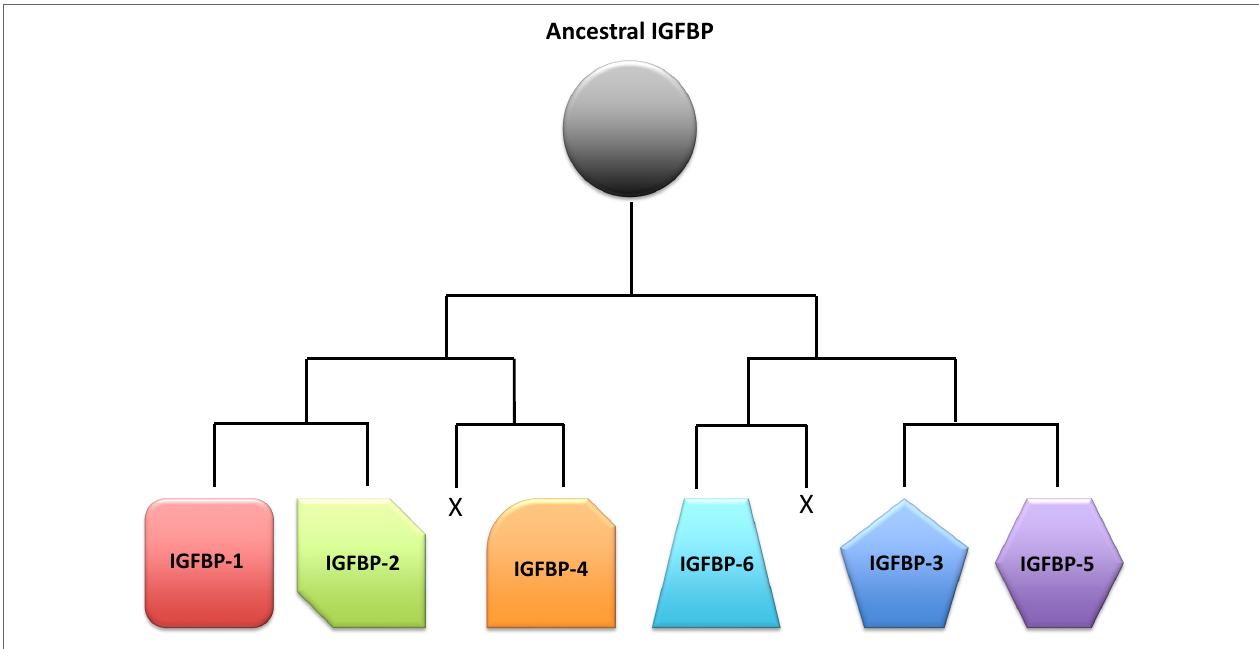
FiGURe 3 | Schematic representation of a proposed scenario of the insulin-like growth factor-binding protein (IGFBP) family evolution. A single ancestral IGFBP gene was duplicated in an early chordate. This duplication was followed by two successive rounds of chromosomal duplications or tetraploidization events in early vertebrates. Of the eight IGFBPs that resulted from this process, two were subsequently lost, leaving six types of IGFBPs that are seen in modern vertebrates.